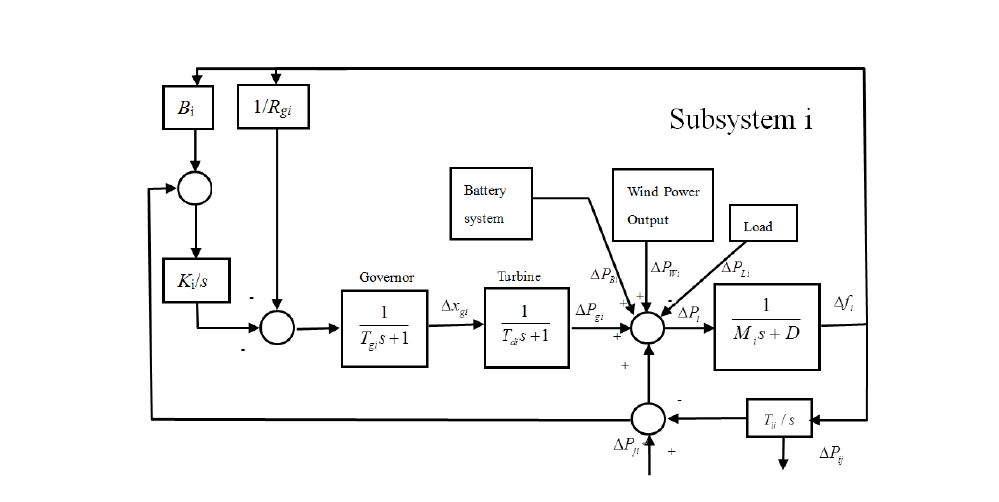
Figure 2. Subsystem